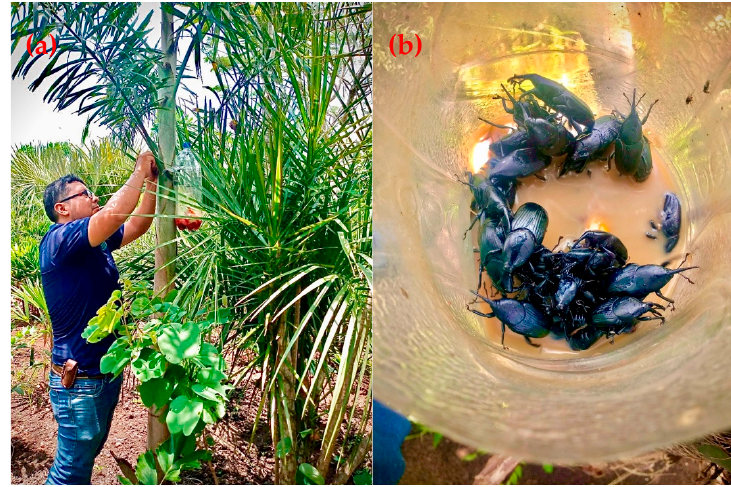
Figure 2. Frontal view of the set traps in 15 ornamental palm plantations in central Veracruz, Mexico. ( a ) The first author is hanging a trap from a palm. ( b ) Collected adult weevils after 4 weeks of trap-food-attractant exposure in an ornamental palm plantation.